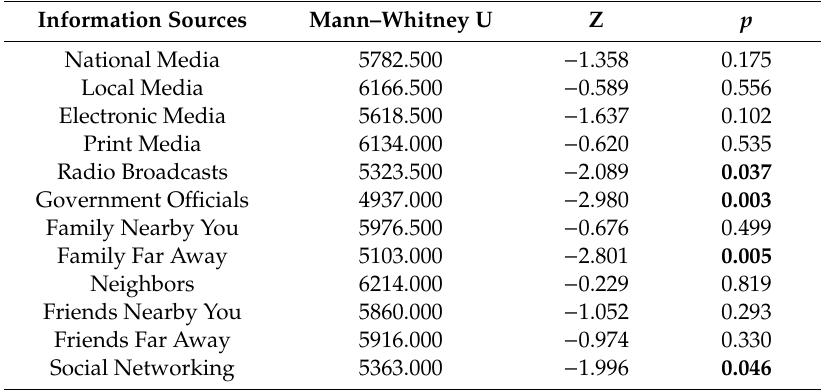
Table 2. Mann–Whitney U results comparing the Stay-at-Home group to the Evacuation group during Hurricane Irma with information sources for radio, government, family, and social networks as